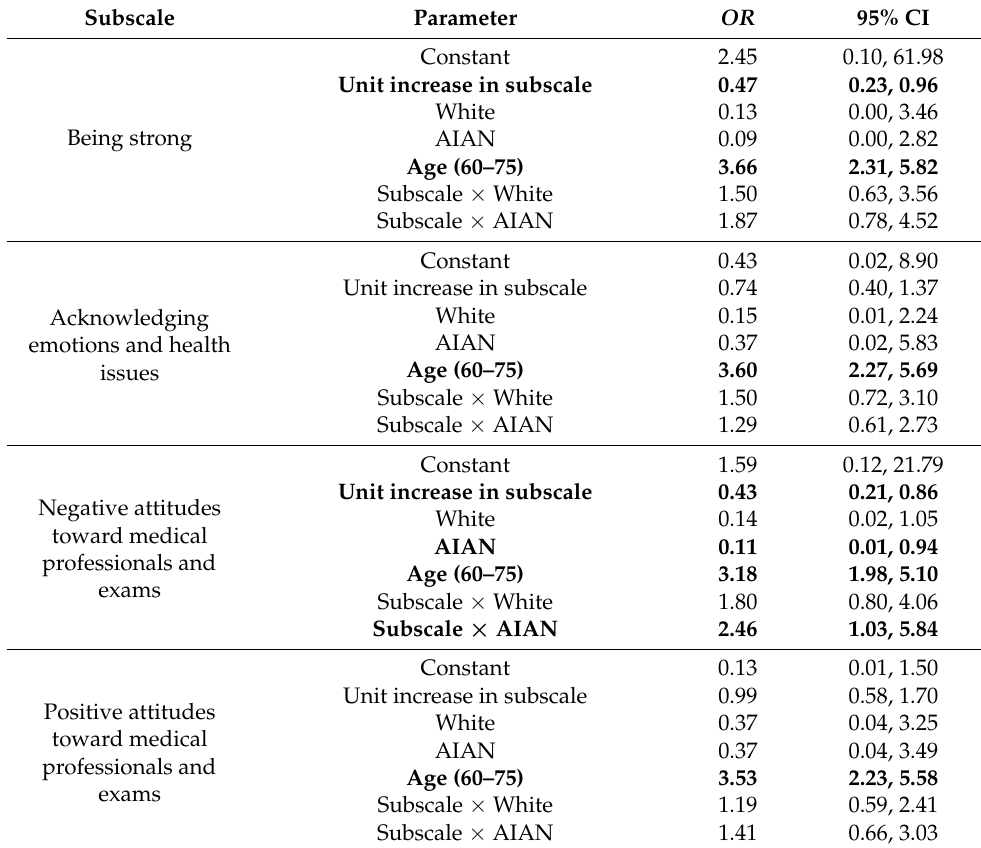
Table A1. Odds ratios (ORs) for the odds of ever having completed colorectal cancer screening among Black, AIAN, and White men (smaller adjusted